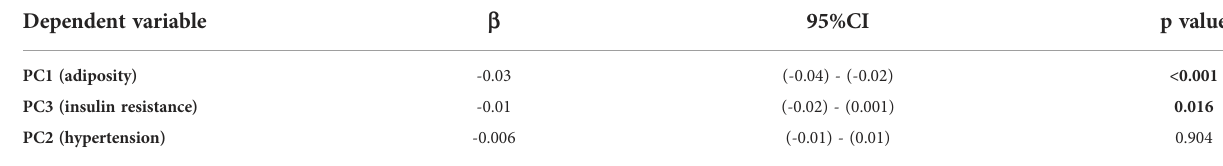
TABLE 4 Regression estimates for each of the three PC derived from PCA, representing adiposity (PC1) insulin resistance (PC3) and hypertension (PC2).